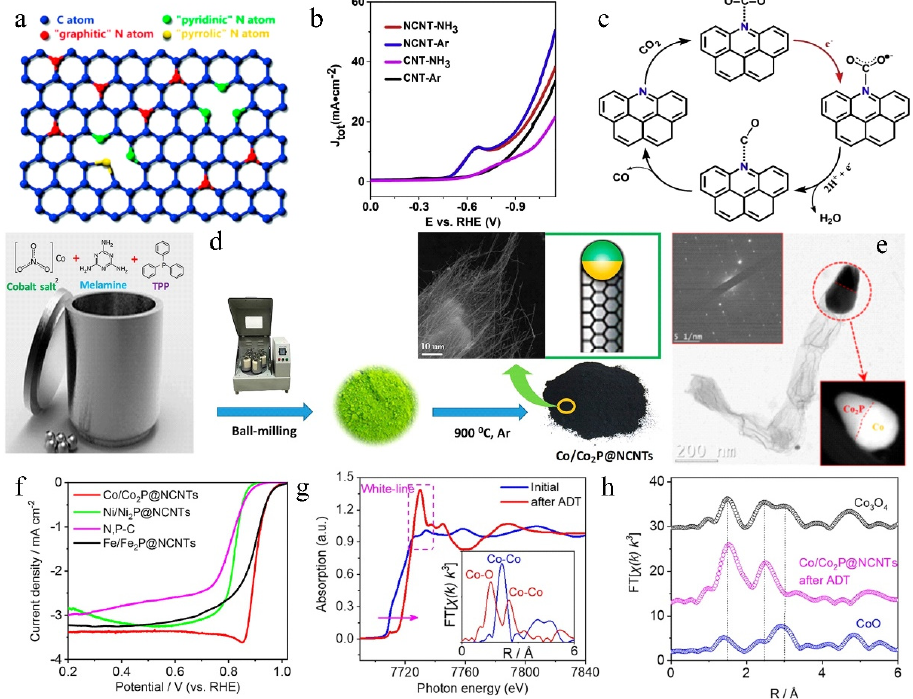
Figure 7. ( a ) Nitrogen doping into carbon plane at different locations. Reproduced with permission [75]. Copyright 2016, Elsevier Ltd. ( b ) LSV curves for NCNT-NH 3 , NCNT-Ar, CNT-NH 3 , and CNT-Ar in CO 2 -saturated 0.5 M NaHCO 3 aqueous solution at 50 mV s − 1 . ( c ) Mechanism of the CO 2 reduction reaction on NCNTs. Reproduced with permission [77]. Copyright 2019, American Chemical Society. ( d ) Schematic procedure for synthesizing the gram-scale Co/Co 2 P@NCNTs. ( e ) TEM images of the Co/Co 2 P@NCNTs. ( f ) ORR polarization plots of the M/M 2 P@NCNTs (M = Co, Ni, or Fe) and the N, P-C (rotation rate of 1600 rpm) in an O 2 -saturated 1.0 M KOH solution. ( g ) Normalized Co K-edge XANES spectra of the Co/Co 2 P@NCNTs before and after the accelerated cycling durability test, and ( h ) the corresponding magnitude Fourier transforms of Co K-edge EXAFS oscillations k 3 χ (k) (k weight of 3). The dashed vertical lines show the Co 3+ -O, Co 3+ Oh-Co 3+ Oh, and Co 2+ Td-Co 3+ Oh distances of 1.48, 2.44, and 3.03 Å, respectively. Reproduced with permission [83]. Copyright 2021, American Chemical